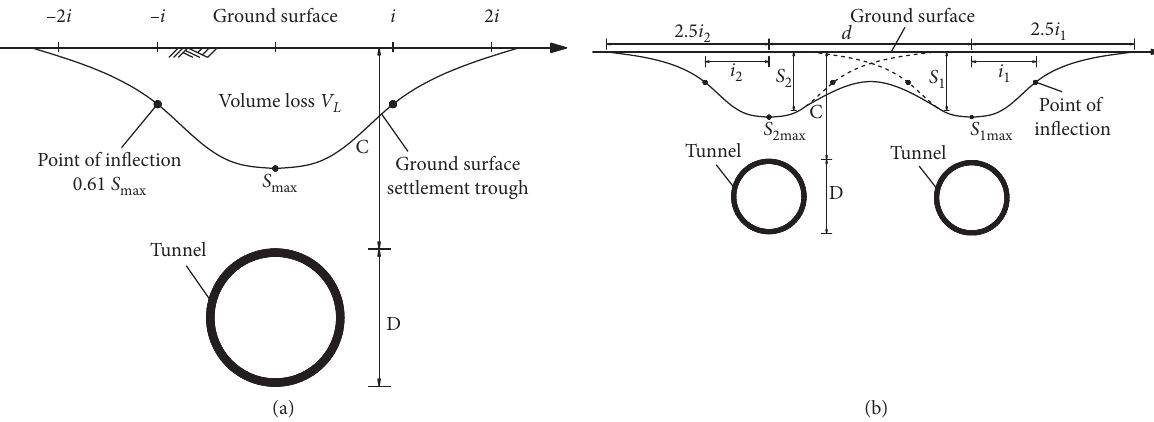
Figure 7: Schematic diagrams of transverse settlement profile induced by: (a) single tunnelling and (b) twin